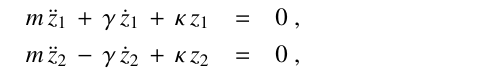
r g ( ✓ ) = r 0 e d g ✓ and r g ( ✓ = n ⇡/ 2) / r 0 = e d g ( n ⇡/ 2) = ( φ ) n (see [17, 57] for the connection with Fibonacci